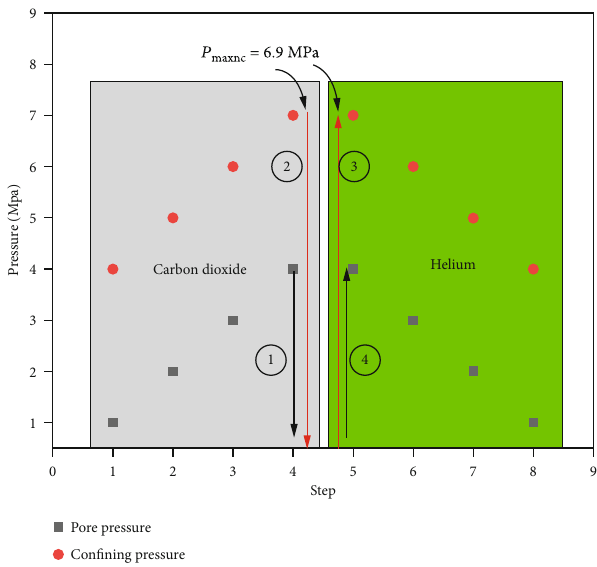
Figure 7: Experimental steps during the